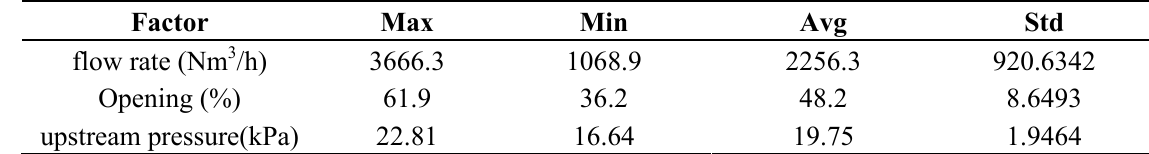
Table2. The descriptive statistical values of the test data.